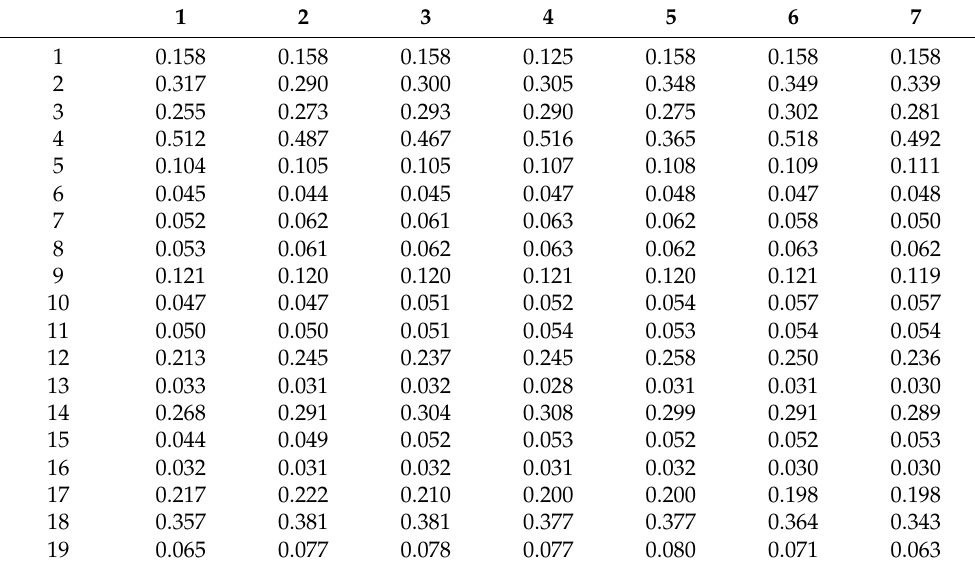
Table A2. Short-term prediction error (RMSE) of the trivial last model—application to 19 tanks, 7-day prediction